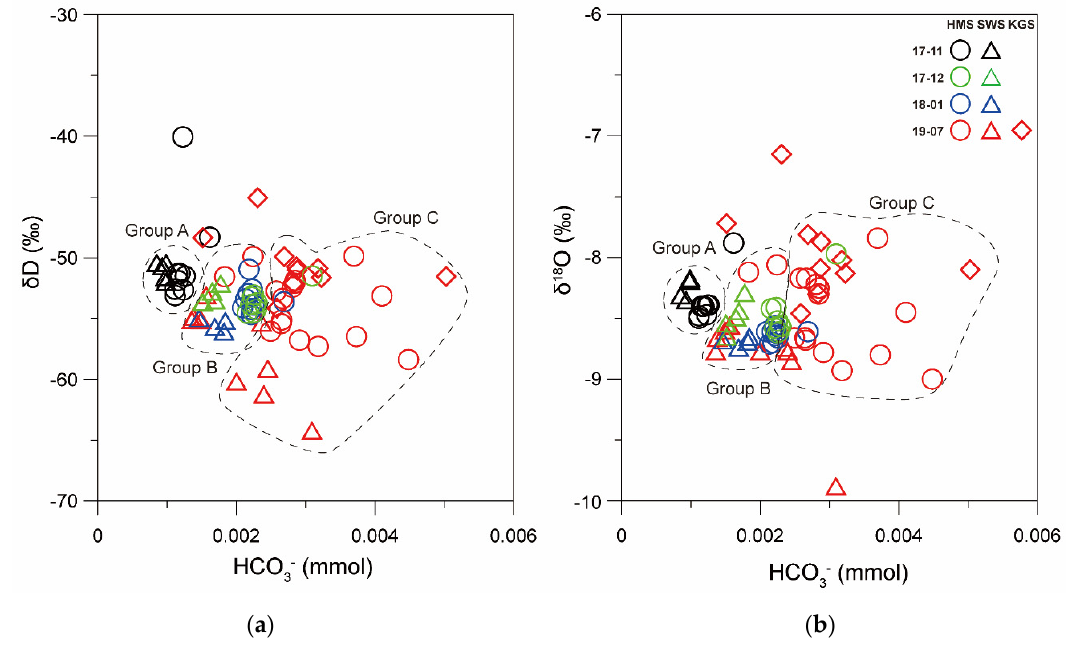
Figure 7. Relationships between stable isotopes ( δ 18 O and δ D) and HCO 3 − for surface waters in Samcheok: ( a ) relationship between δ D and HCO 3 − , and ( b ) relationship between δ 18 O and HCO 3 − .